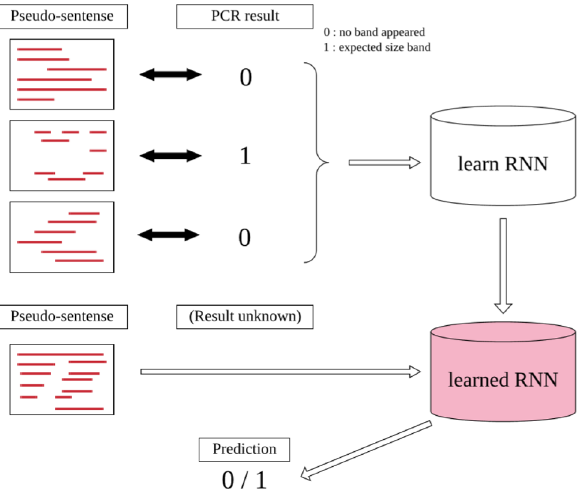
Figure 3. Learning and prediction by RNN. Schematic diagram of how to learn pseudo-sentences by RNN. The upper row shows the processing during learning, and the lower row shows the processing during testing. The learning results are saved in the file specified by PyTorch, read during the test, and used for prediction